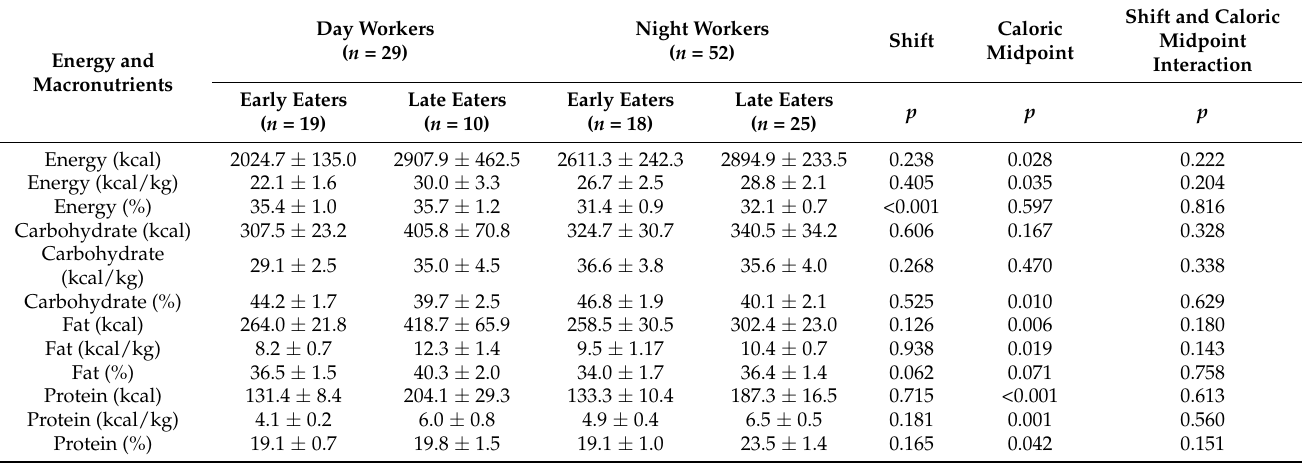
Table 3. Comparison of daily energy and macronutrient consumption of early eaters and late eaters according to the